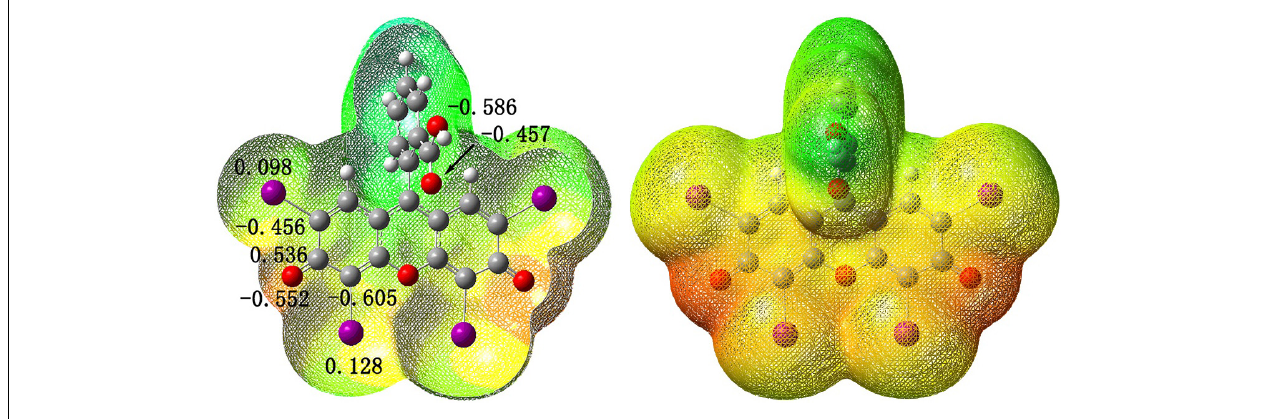
FIGURE 4 | Potential electronic diagram and selected atomic charges of Ery −